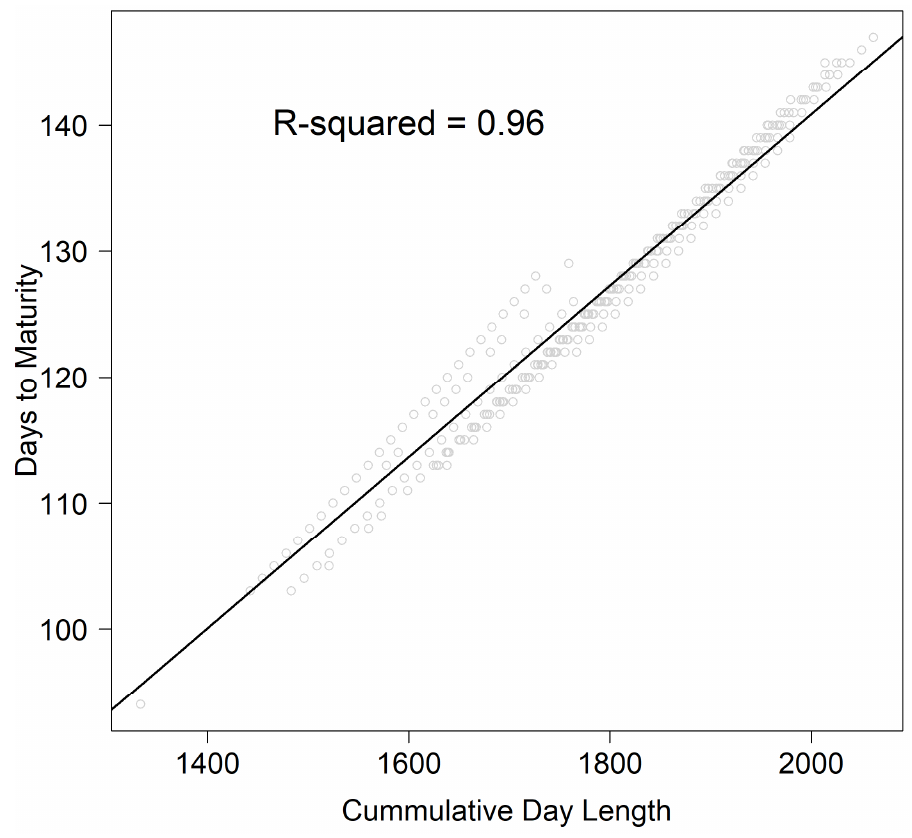
Figure 4. Scatter plot of DTM ( y -axis) of 367 soybean genotypes observed in 11 environments as a function of cumulative daylength ( x- axis).